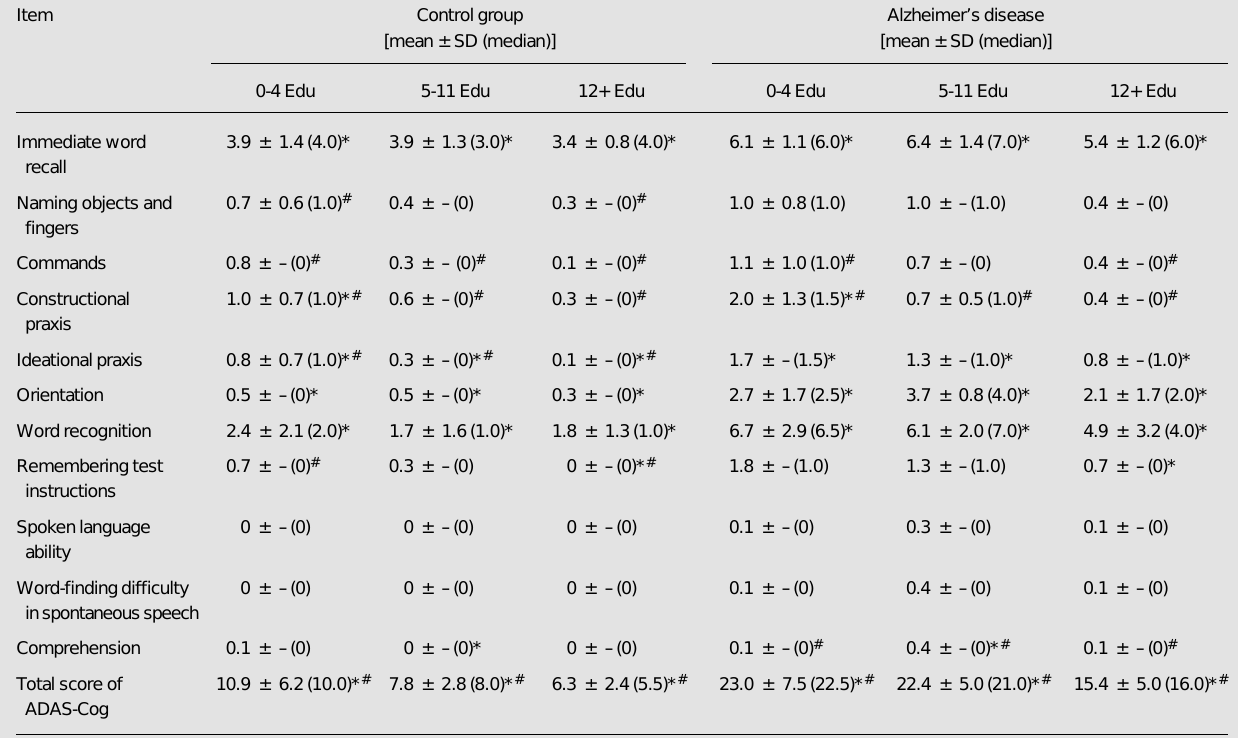
Table 2. Scores for the items of the cognitive subscale of the Alzheimer’s Disease Assesment Scale (ADAS-Cog) obtained for a control group and for Alzheimer’s disease patients with educational levels between 0 and 4 years of schooling (0-4 Edu), 5 and 11 years of schooling (5-11 Edu) and 12 or more years of schooling (12+